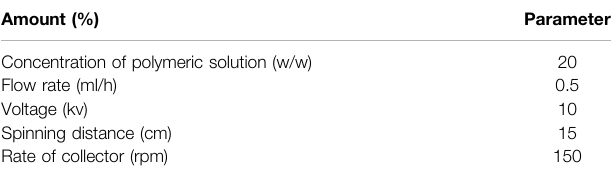
TABLE 1 | Electrospinning parameters for the synthesis of nano fi bers. Amount (%) Parameter Concentration of polymeric solution (w/w)